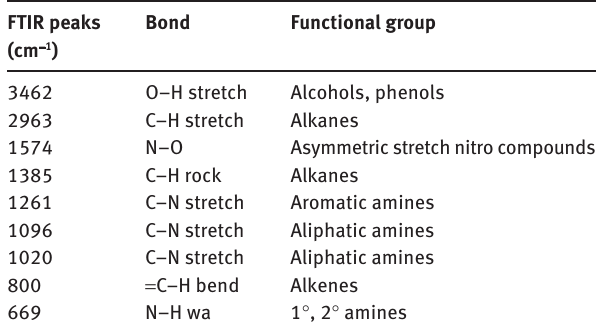
Table 1: IR peaks for FDNPs synthesized via green hydrothermal route with reducing agents of P. cerasifera leaf